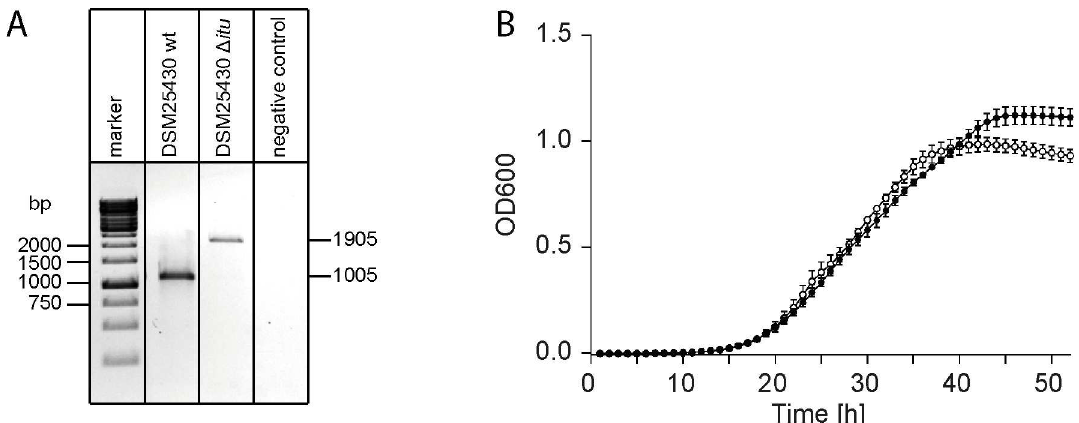
Fig 4. Verification of the paenilarvin gene cluster inactivation mutant P . larvae DSM25430 Δ itu . (A) PCR analysis of the genomic region of P . larvae DSM25430 Δ itu with primers flanking the insertion site in the malonyl CoA-ACP transacylase gene of the paenilarvin gene cluster revealedsuccessful intron insertion. The ampliconsof the wild-type strain and of the mutant strain carrying the insertion migrated at their expected sizes of 1005 bp and 1905 bp, respectively. (B) Growth curves of the wild-type strain P . larvae DSM25430wt (closed circles) and the mutant strain DSM25430 Δ itu (open circles) in liquid broth did not differ significantly(two-way-ANOVA, p-value = 0.15). Data points represent the mean ± SEM and consisted of three biologicalreplicates with three technical replicateseach.